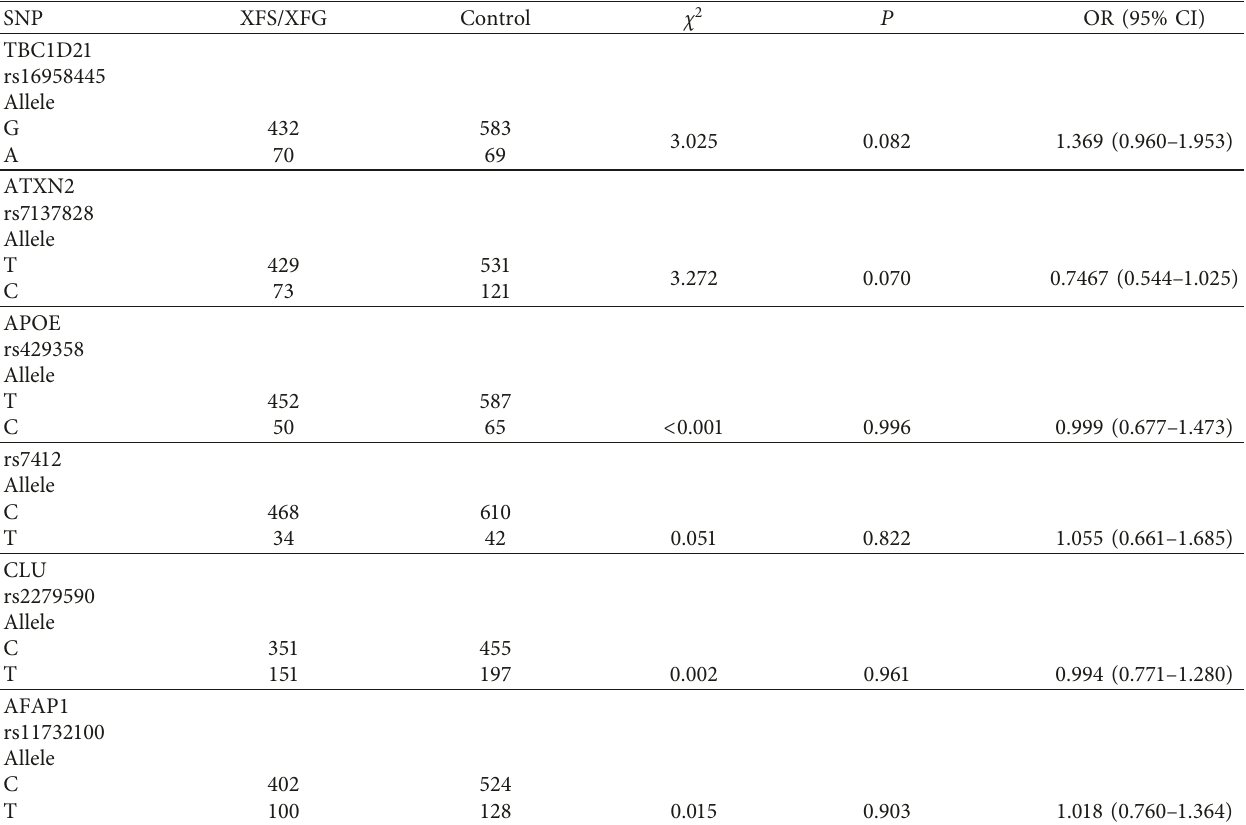
Table 3: Allele association analysis with these